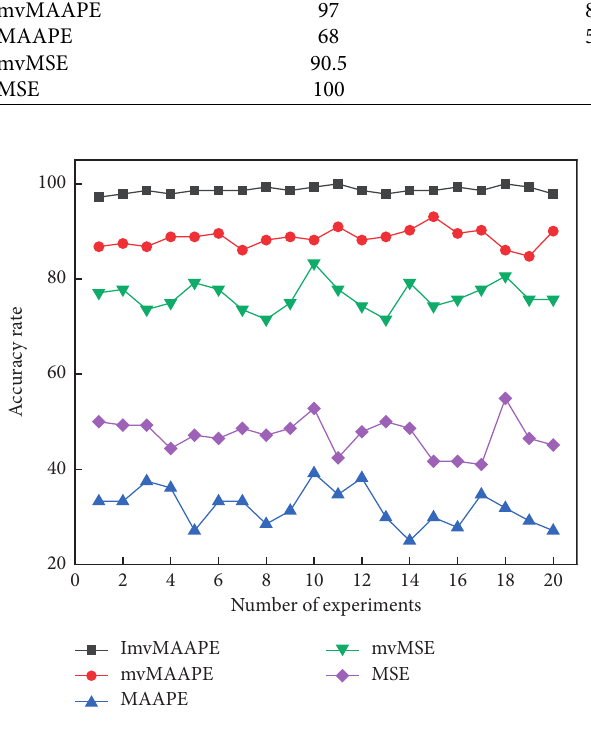
Figure 21: The gearbox experiment results of different entropies.